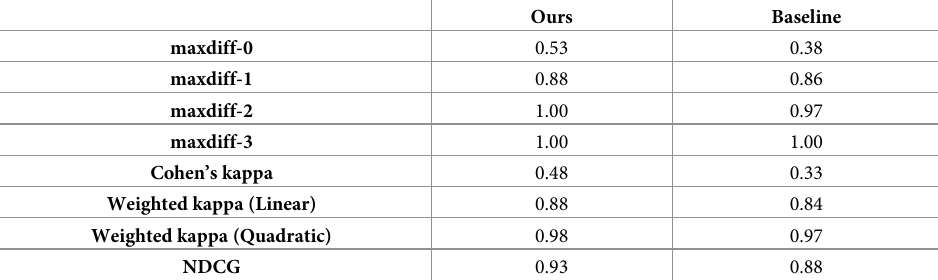
Table 5. Metrics of performance for our phenology prediction model and the baseline model.